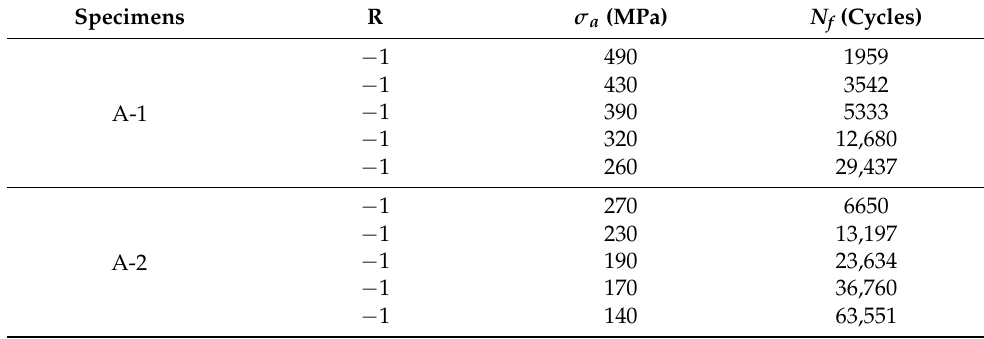
Table 3. Fatigue test data of TC4 alloy under loadings, data from